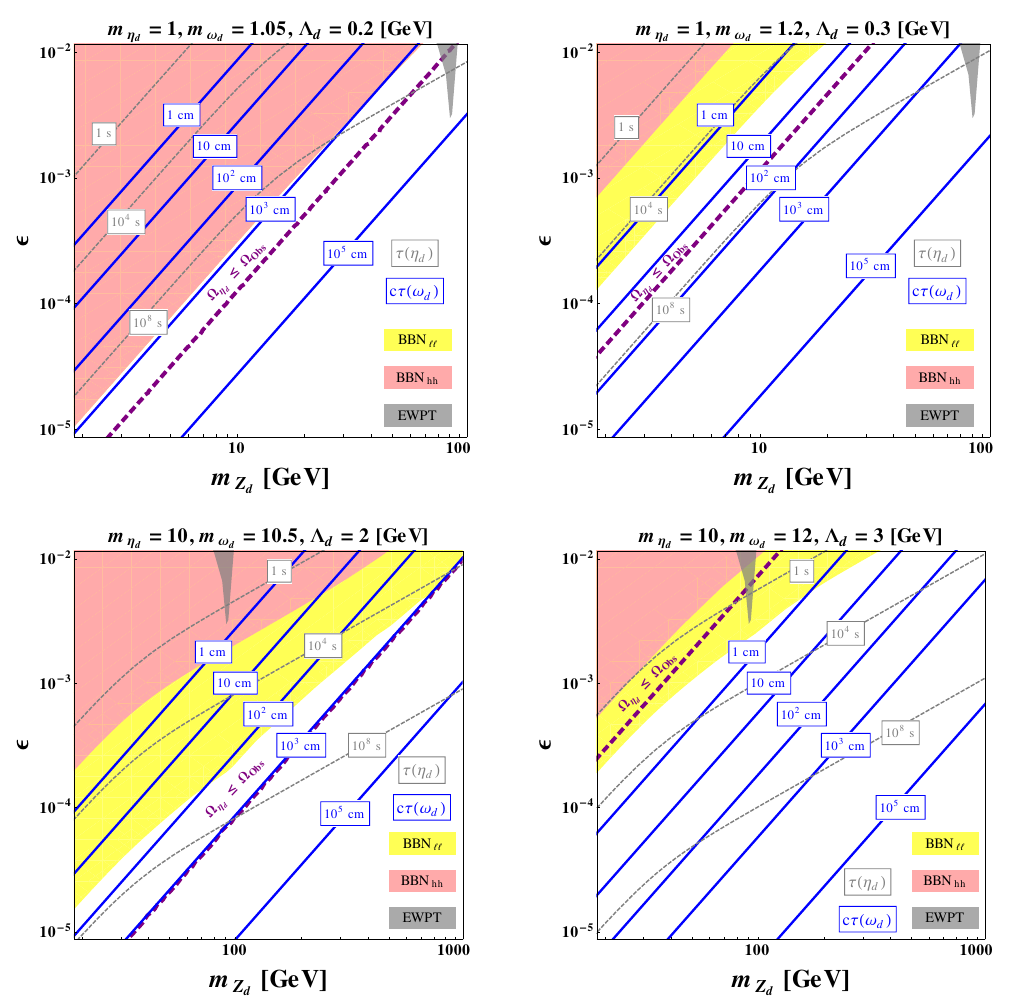
Figure 4 . BBN bounds on the photon portal scenario with two choices of m (cid:17) d and ( m ! d =m (cid:17) d ) ratio. We consider scenarios with m q > (cid:3) d . The pink (yellow) regions give the allowed dark photon d mass and mixing from the BBN constraints if Z d decays dominantly into SM hadrons (leptons). As a reference, the dashed purple line corresponds to the parameters when the (cid:17) d abundance equals the observed DM abundance before it decays. The gray shaded region is the parameter space excluded by the current electroweak precision test data. Blue (gray) curves give lifetimes of ! d ( (cid:17) d ) from the estimates in eq. (3.3), (3.2). Notice that the range of m Z values are di(cid:11)erent between the upper d and lower plots.